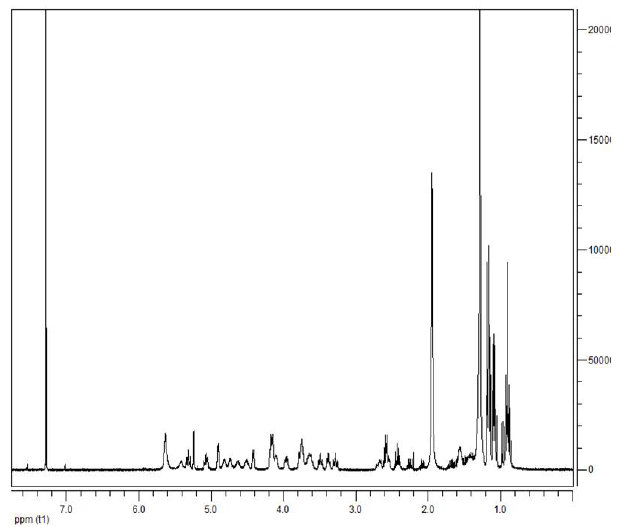
Fig 1 . 1 H nuclear magnetic resonance of the major sugar ester compound isolated from S.